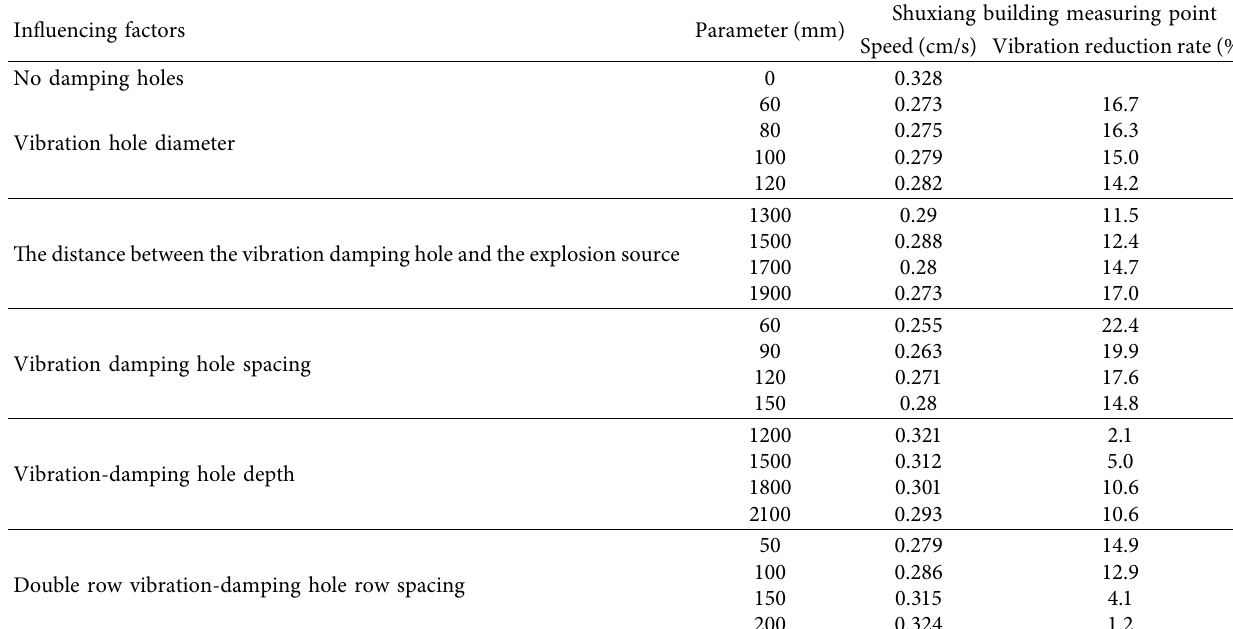
Table 8: Field test data and corresponding damping